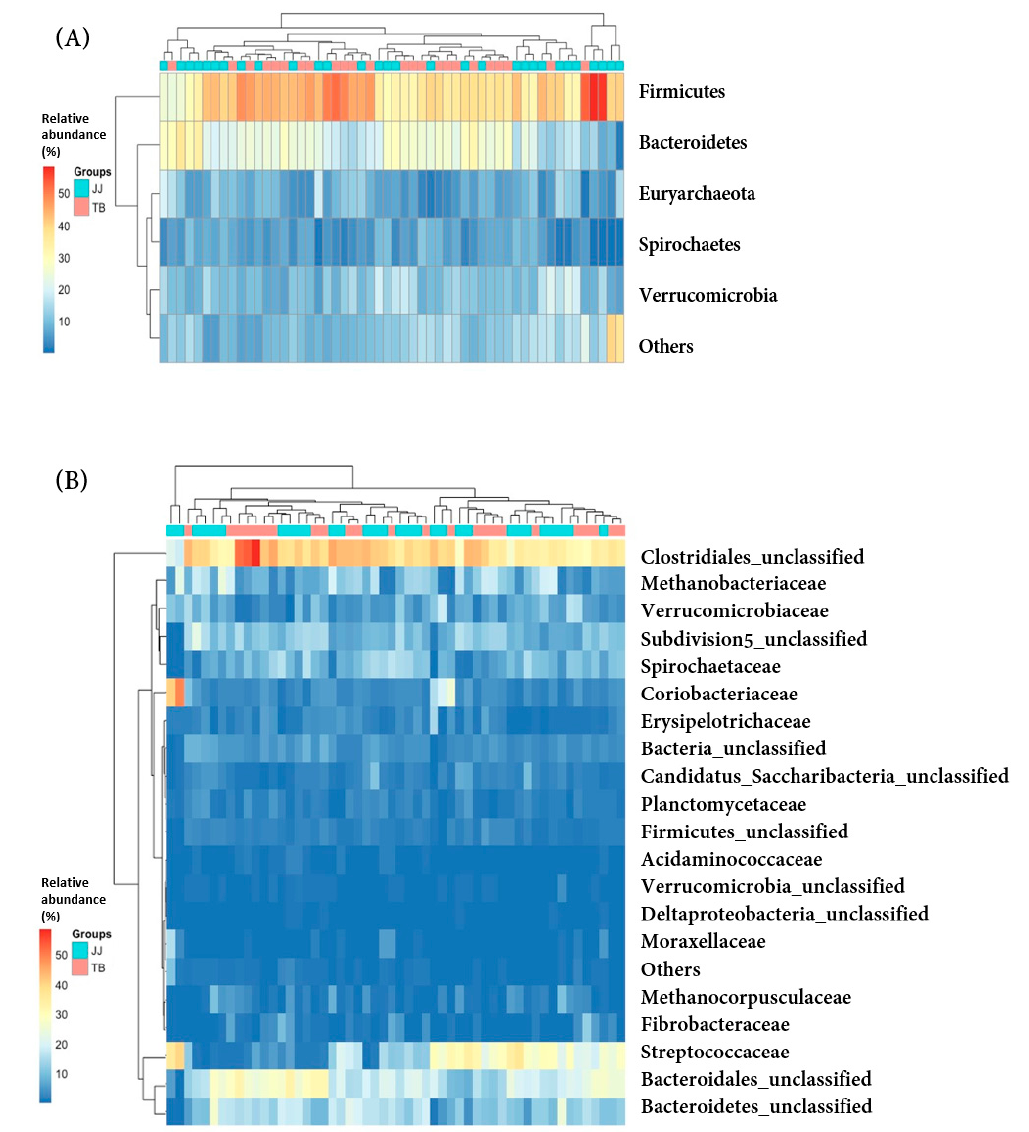
Figure 3. Heatmap profile showing the relative abundance of the phylotype between Jeju and Thoroughbred horses at the phylum ( A ) and family ( B ) levels of Jeju and Thoroughbred horse. JJ; Jeju horse, TB; Thoroughbred horse.